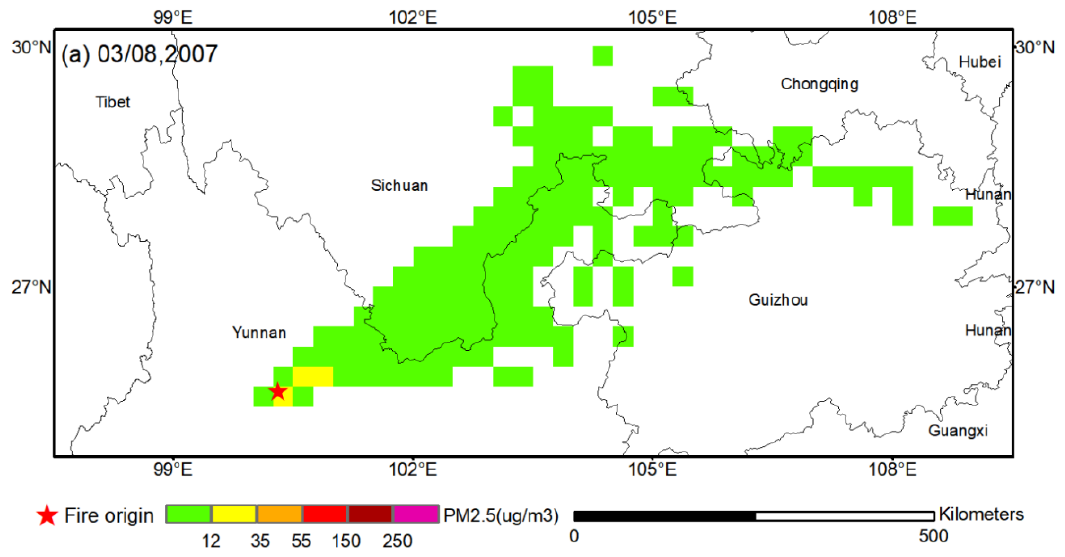
Figure A9. Same as Figure A1 except for the Dali fire on 8 March 2007.